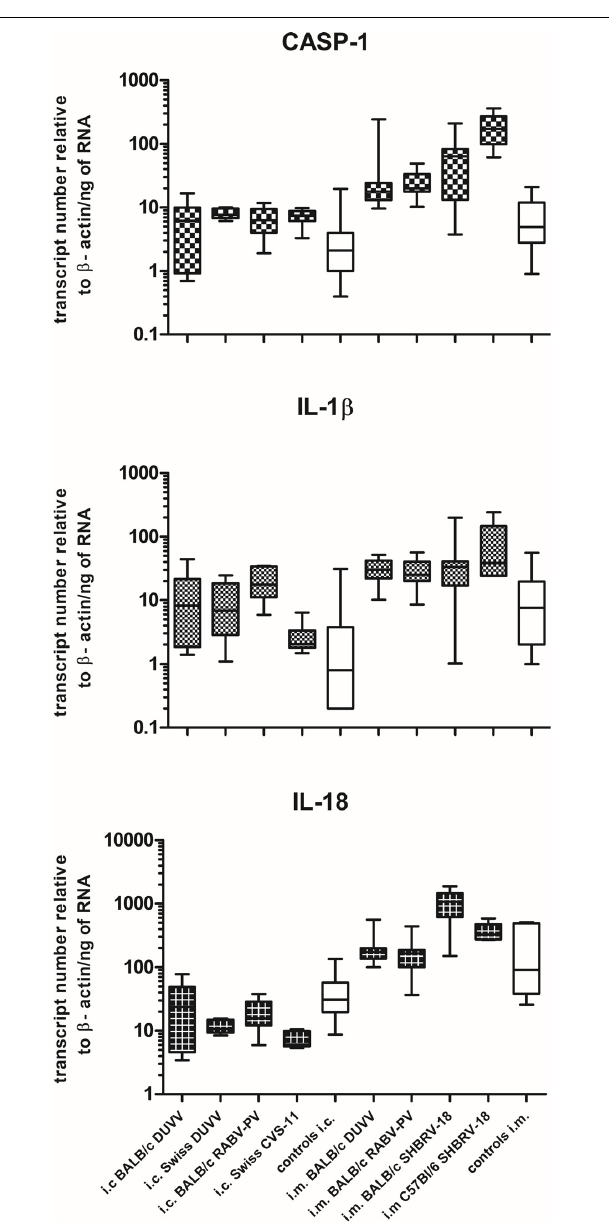
FIGURE 6 | Pyroptosis is activated in different mouse strains after infection with different lyssaviruses. Shaded boxes represent virus-infected mice of the respective mouse strains. Open boxes represent pools of BPL and/or mock-inoculated mice of the respective mouse strains. Actual mean numbers are given in Table 4 for each